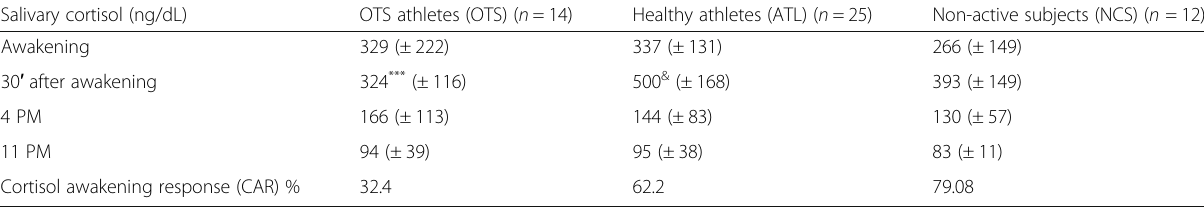
Table 5 Mean and SD of salivary cortisol rhythm Salivary cortisol